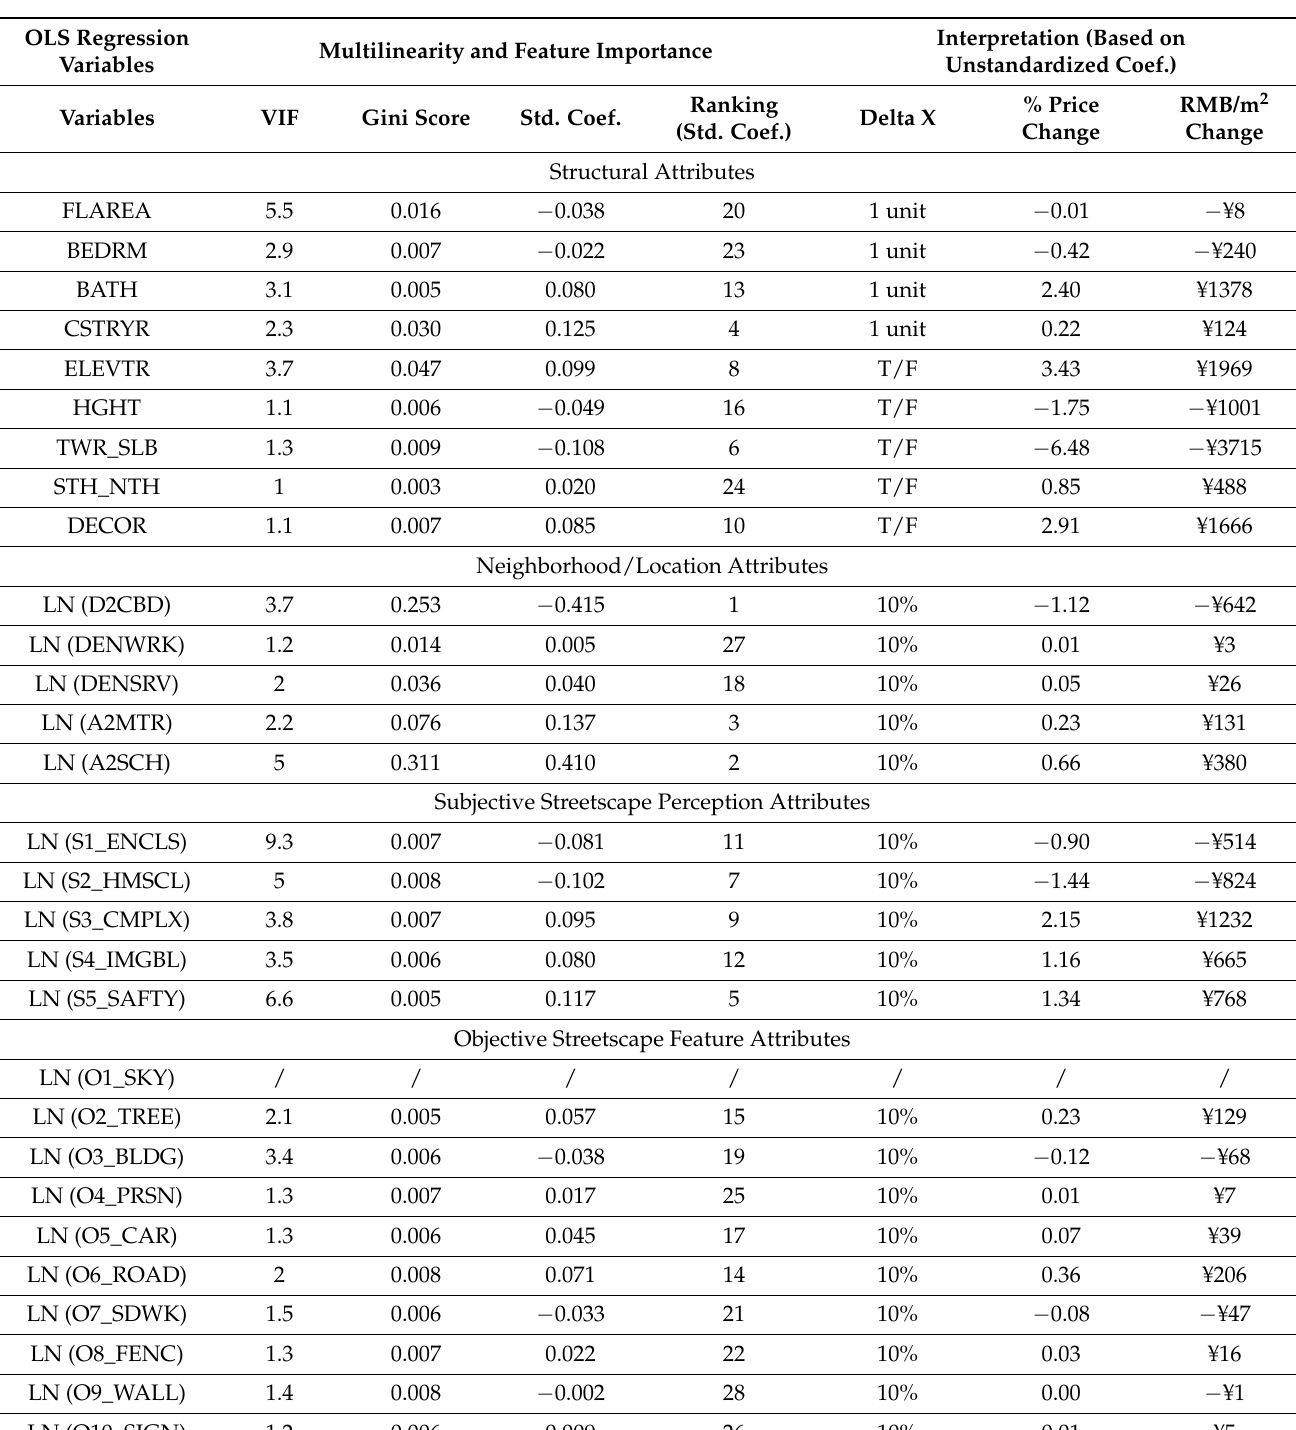
Table 3. OLS regression model for comparison and